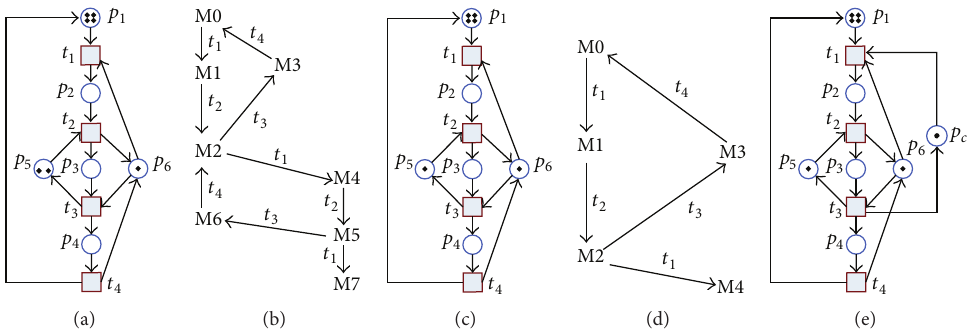
Figure 1: (a) A plant model (𝑁,𝑀 0 ) , (b) the reachability graph of (𝑁,𝑀 0 ) , (c) a modified model (𝑁 1 , 𝑀 1 ) , (d) the reachability graph of (𝑁 1 , 𝑀 1 ) , and (e) a controlled system (𝑁 1𝑐 , 𝑀 1𝑐 ) for (𝑁 1 ,𝑀 1 ) .